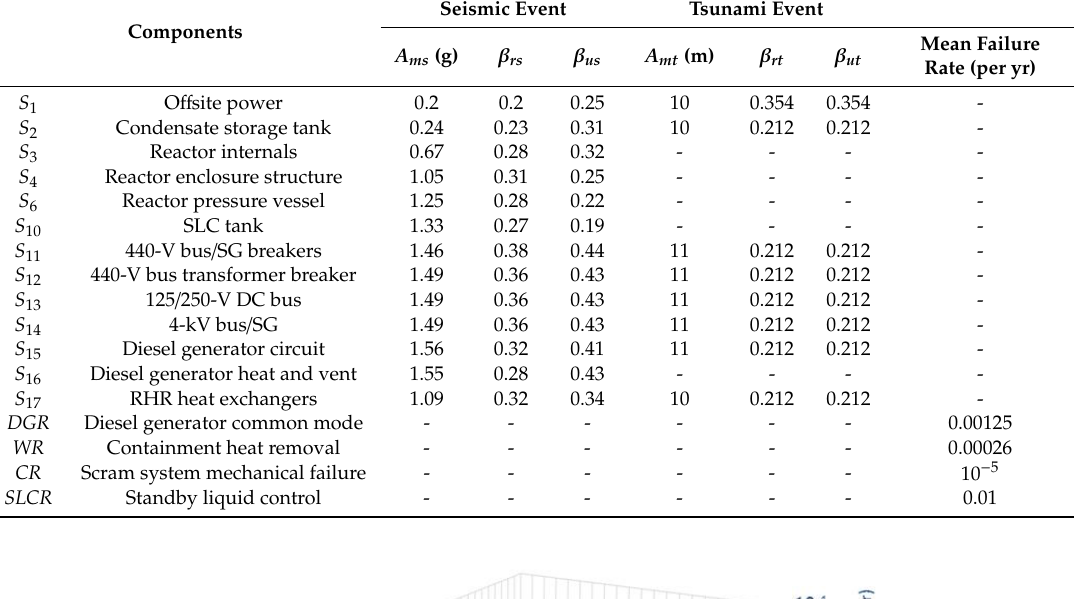
Table 6. Multi-hazard component fragility and random failure probability information of the LGS nuclear power plant.